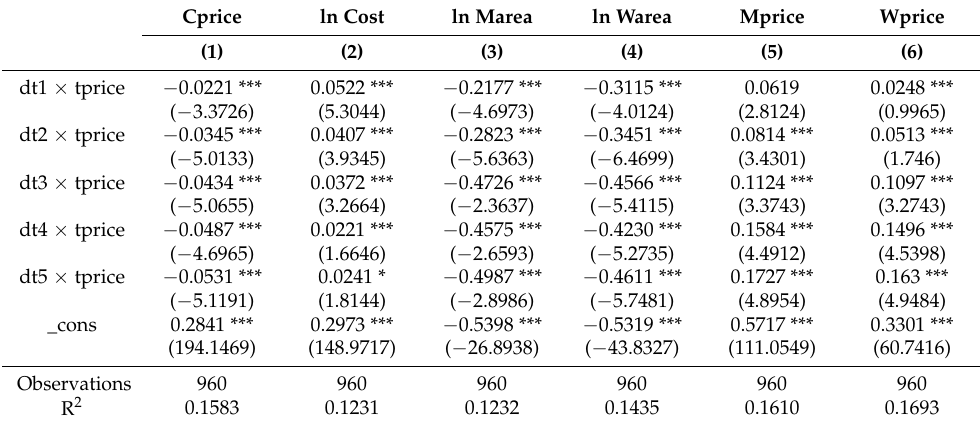
Table 7. Impact of target price policy on cotton and competitive crop